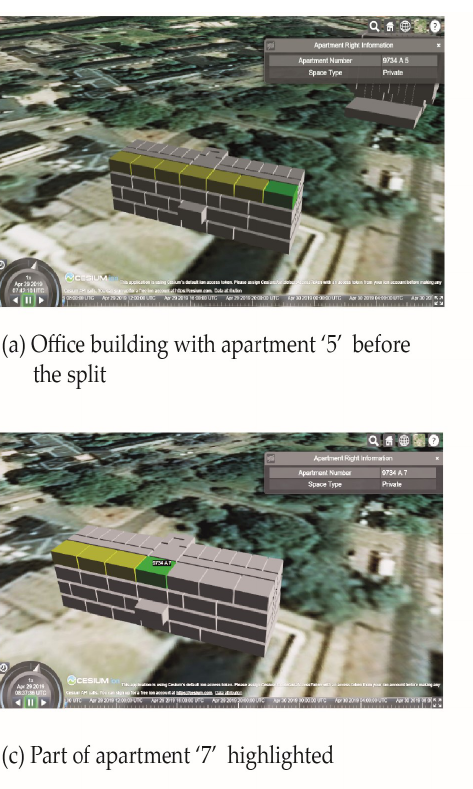
Figure 7. Visualization at the 3D web-based prototype. Example of o ffi ce building splitting apartment 5 ( a ) into apartments 6 ( b ) and 7 ( c ) visualised in Cesium JS. The shared space is highlighted in ( d )